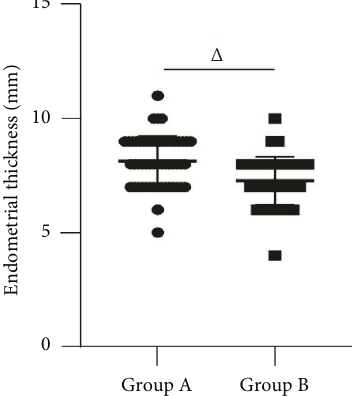
Figure 3: Time of menstruation return. Note . Δ indicates P < 0 . 005 for the difference between groups A and B.